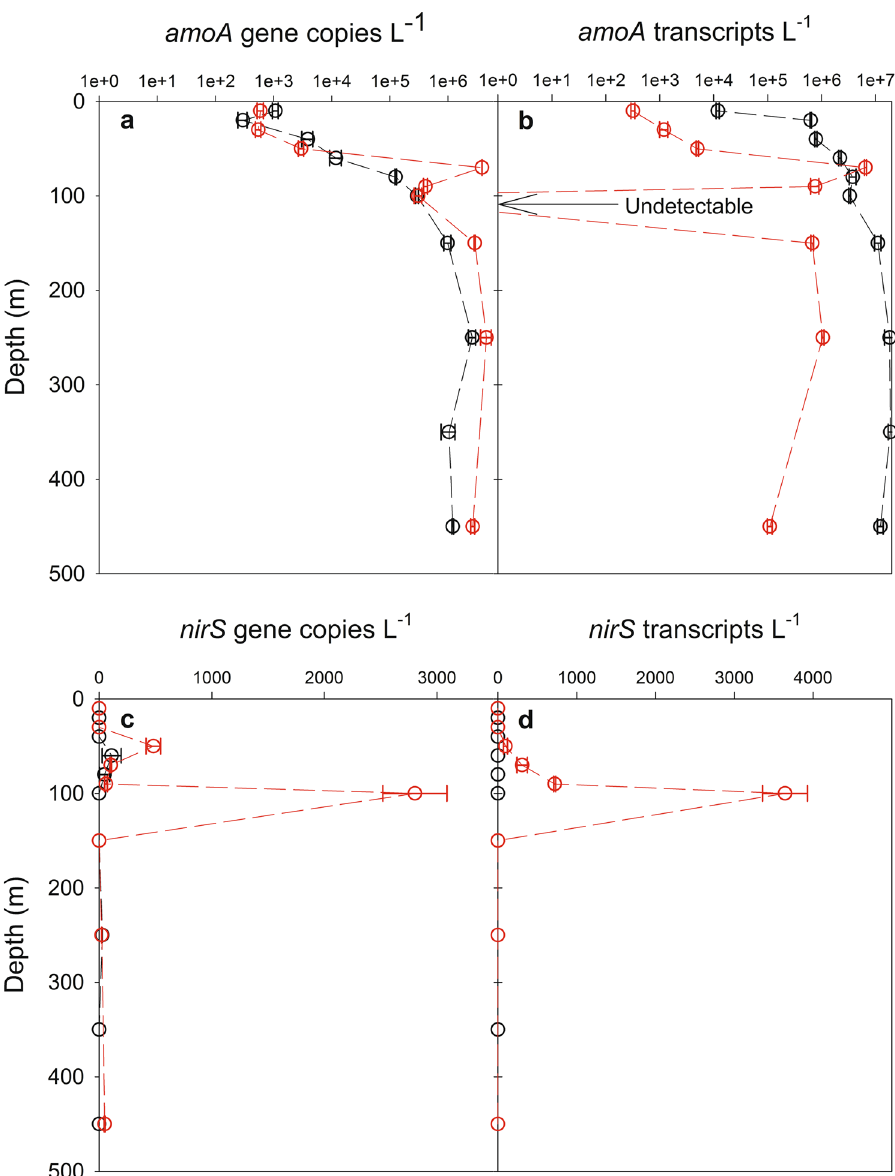
Figure 6. Vertical distributions of ( a ) amoA gene copies, ( b ) amoA transcripts, ( c ) nirS gene copies and ( d ) nirS transcripts at ES1 (red circles) and OES (black circles). The error bars represent the standard deviation of duplicate measurements. Note: the amoA and nirS gene data were also included in a description of the microbial community within the eddy by Löscher et al . 21